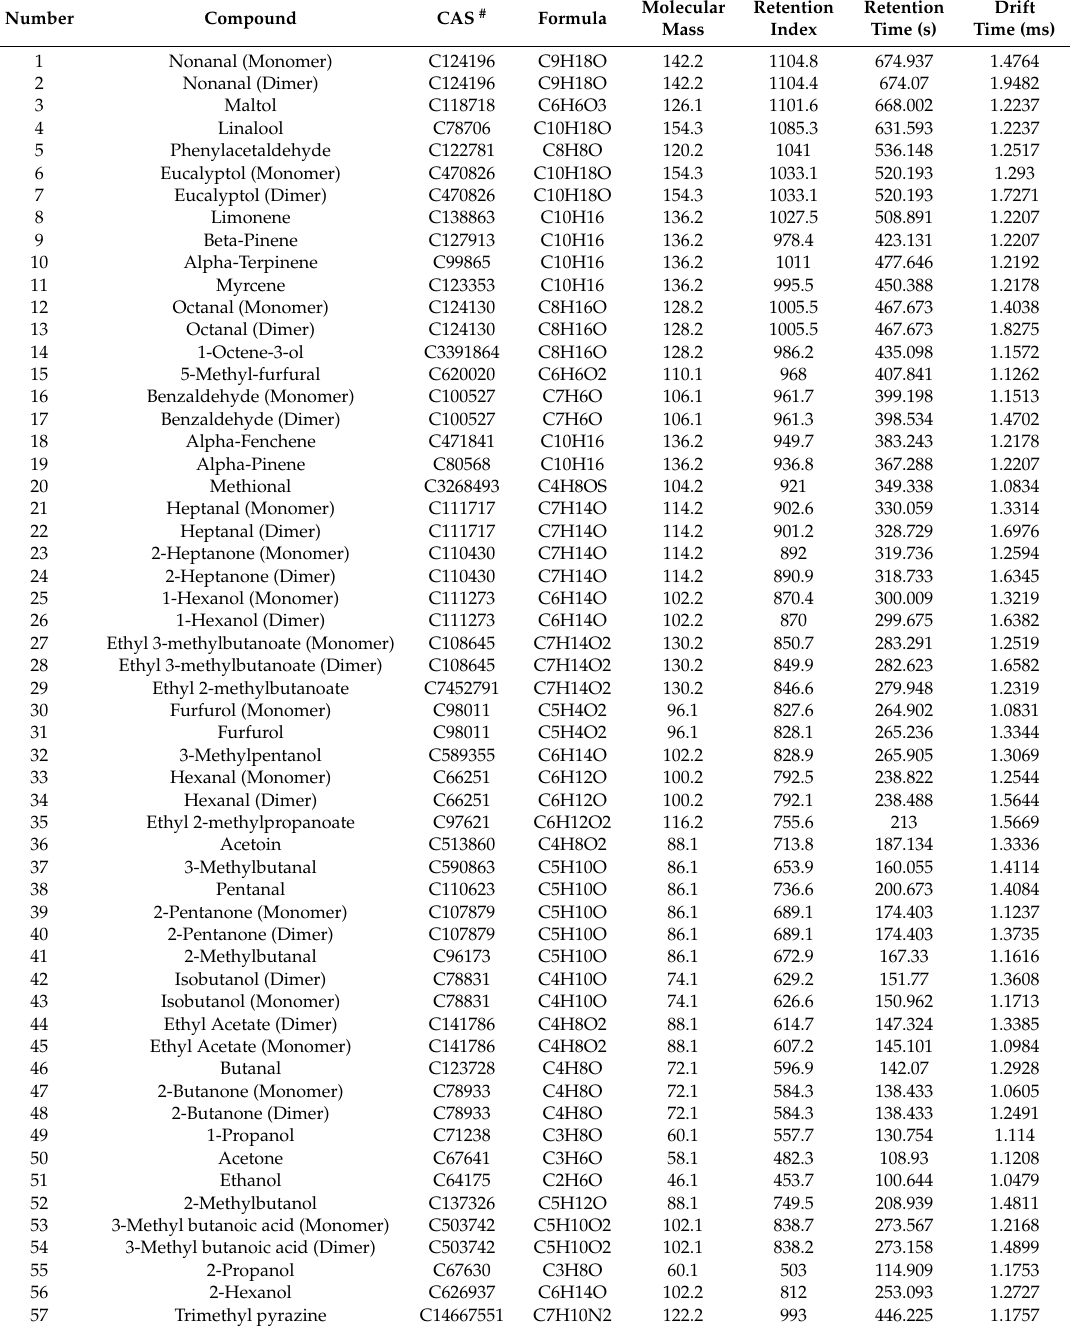
Table 2. The information on identified compounds of dry-cured beef during